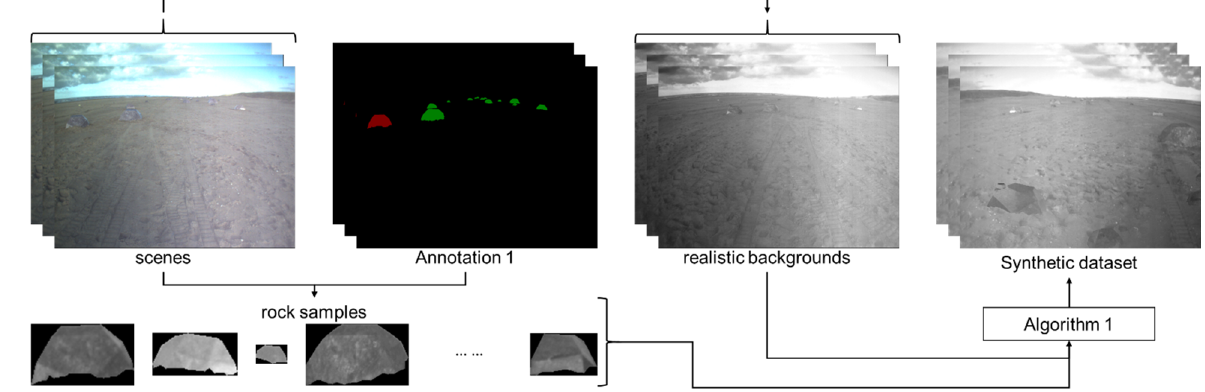
Figure 3. The preparation part in the implementation of the proposed synthetic algorithm. “Annotation 1” refers to the same “Annotation-1” as in Figure 1. The red and green pixels in “Annotation 1” refer to the rock samples and other rocks, respectively.